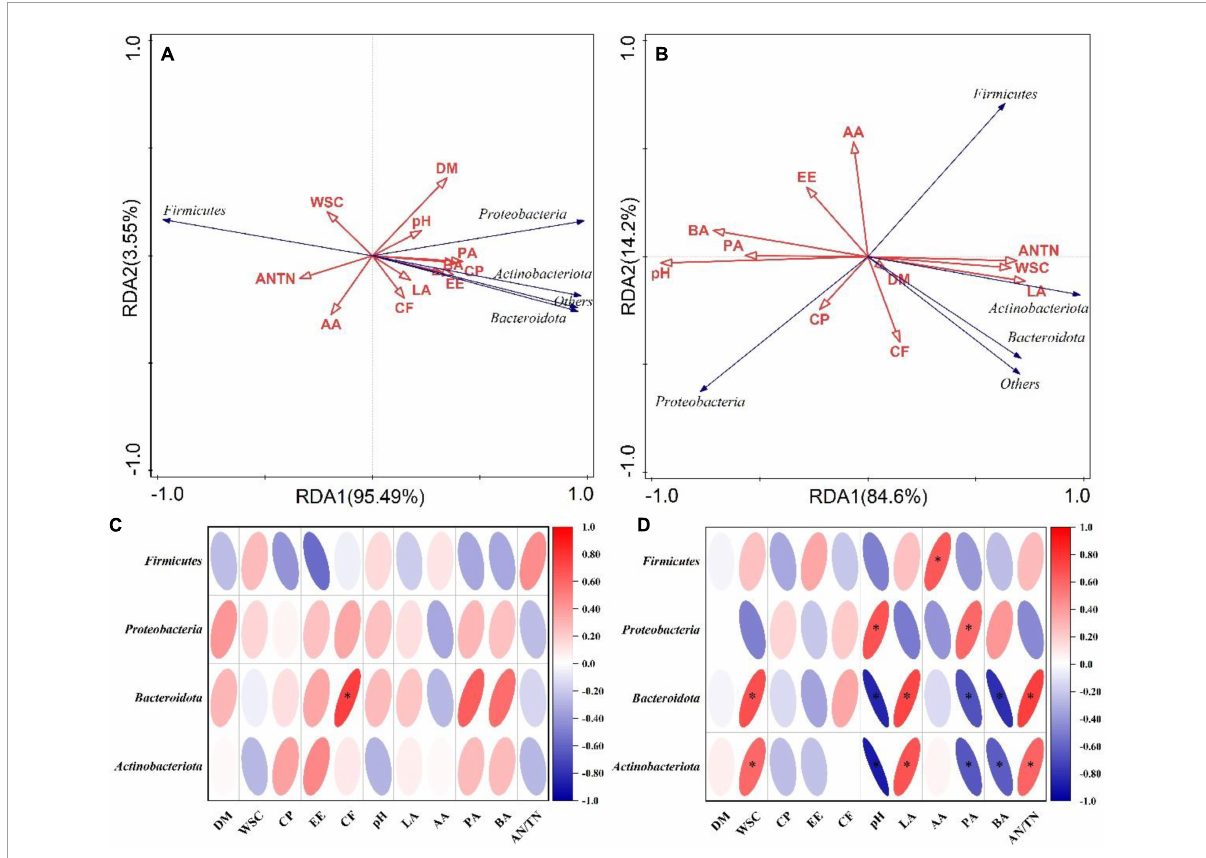
FIGURE3 The RDA plots showing the effects of chemical composition and fermentation products on the bacterial community structure at the phylum level at flowering (A) and maturing stage (B) . Spearman correlation heatmap showed the relationship between bacterial classification at the phylum level at flowering (C) and maturing stage (D) , and environmental variables (chemical composition and fermentation products). ∗ indicated the level of significance at p < 0.05. AA, acetic acid; AN/TN, ammonia-N in total N; BA, butyric acid; CF, crude fiber; CP, crude protein; DM, dry matter; EE, ether extract; LA, lactic acid; PA, propionic acid; WSC, water-soluble